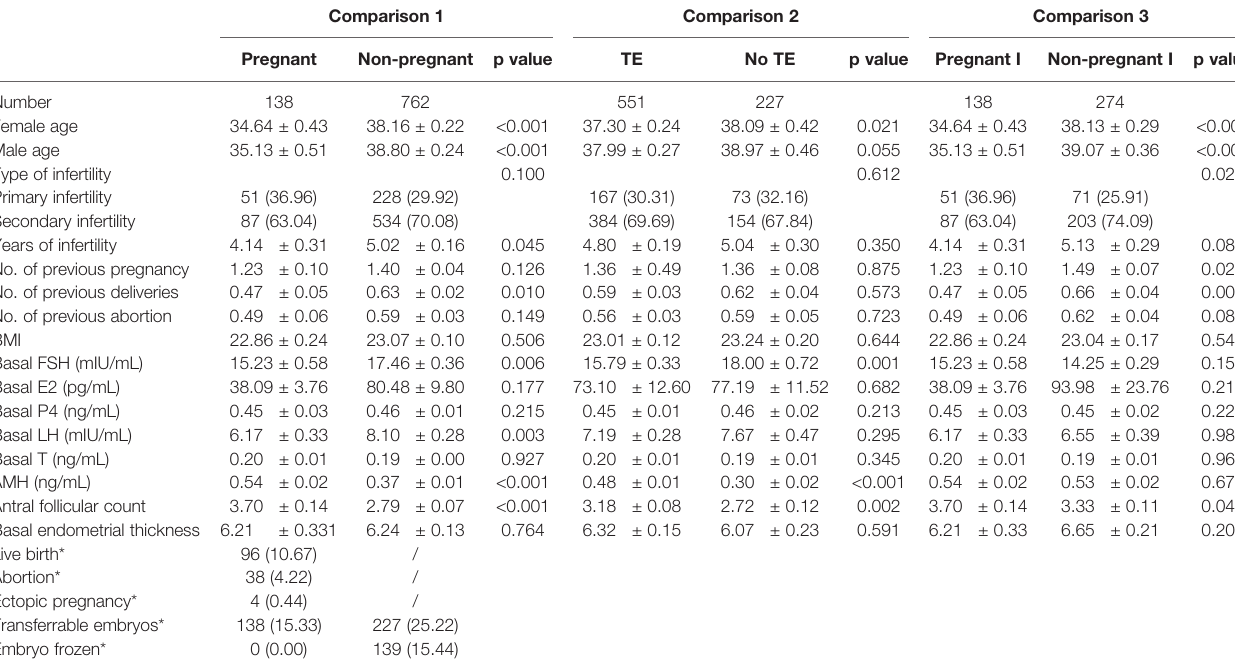
TABLE 1 | Baseline characteristics and hormonal pro fi les between groups of women with DOR undergoing IVF/ICSI. Comparison 1 Comparison